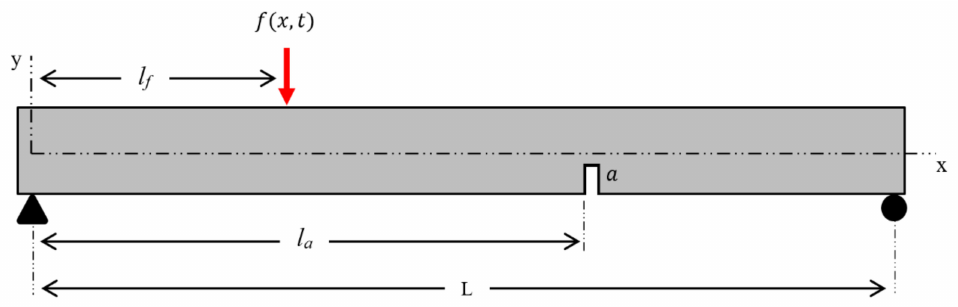
Figure 2. Configuration of a simply supported